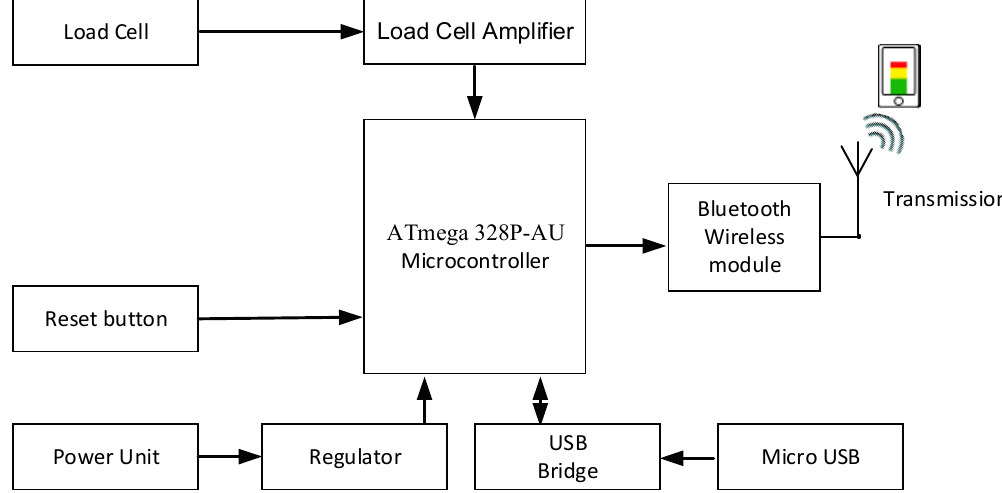
Figure 2. Structure of urine pot measuring module.